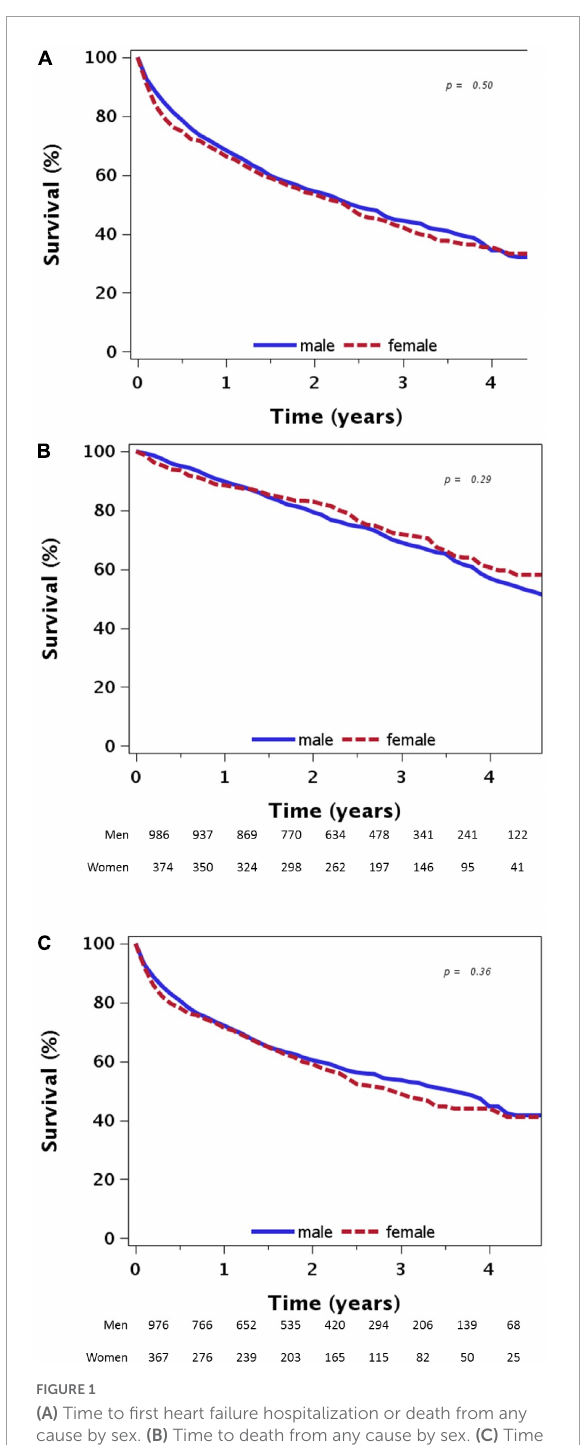
FIGURE1 (A) Time to first heart failure hospitalization or death from any cause by sex. (B) Time to death from any cause by sex. (C) Time to first heart failure hospitalization by